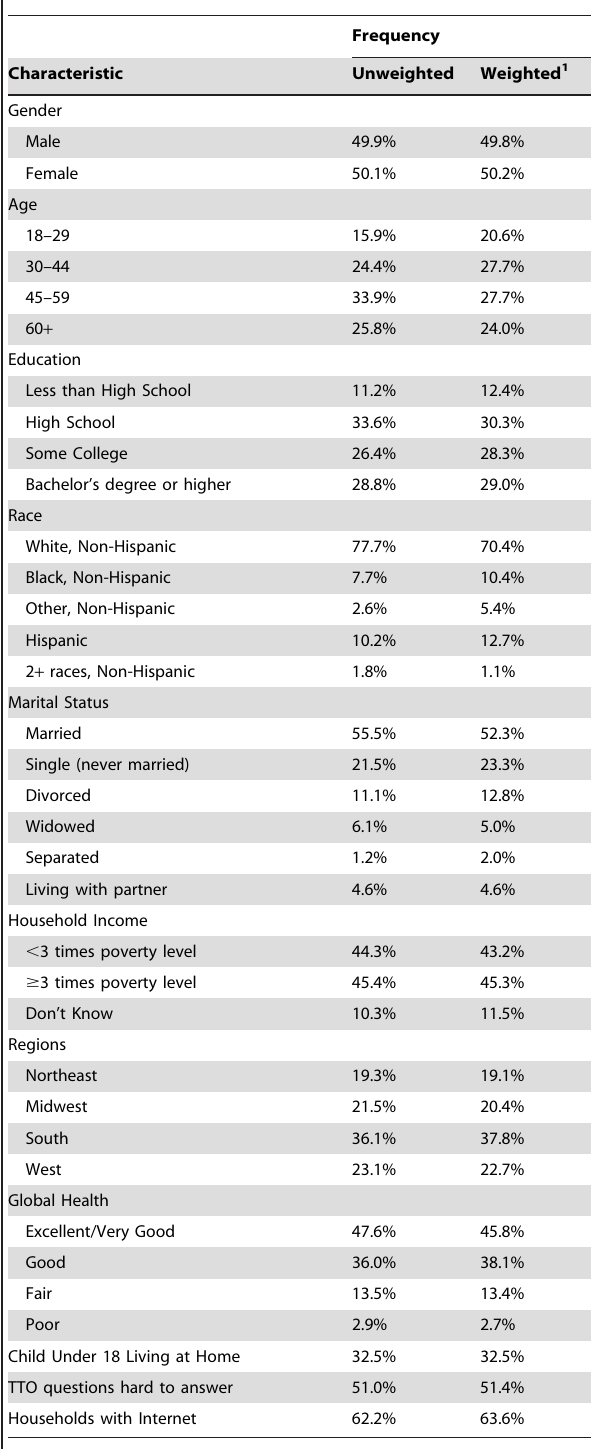
Table 1. Respondent demographic characteristics